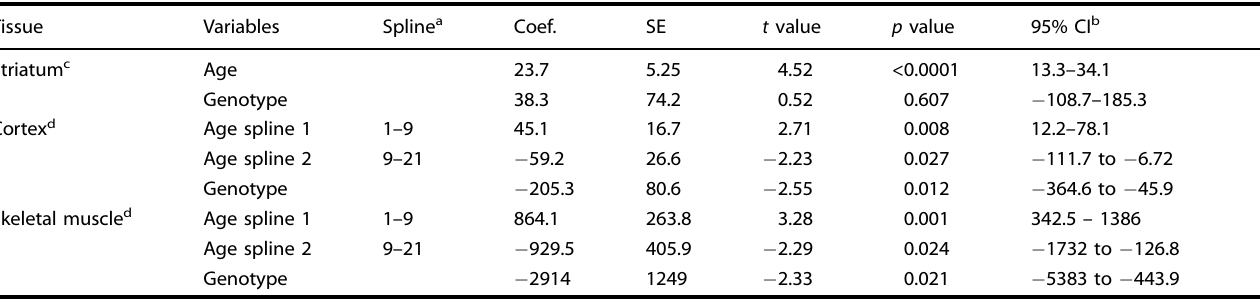
a Spline indicates the knots in the cubic spline regression. b 95% con fi dence